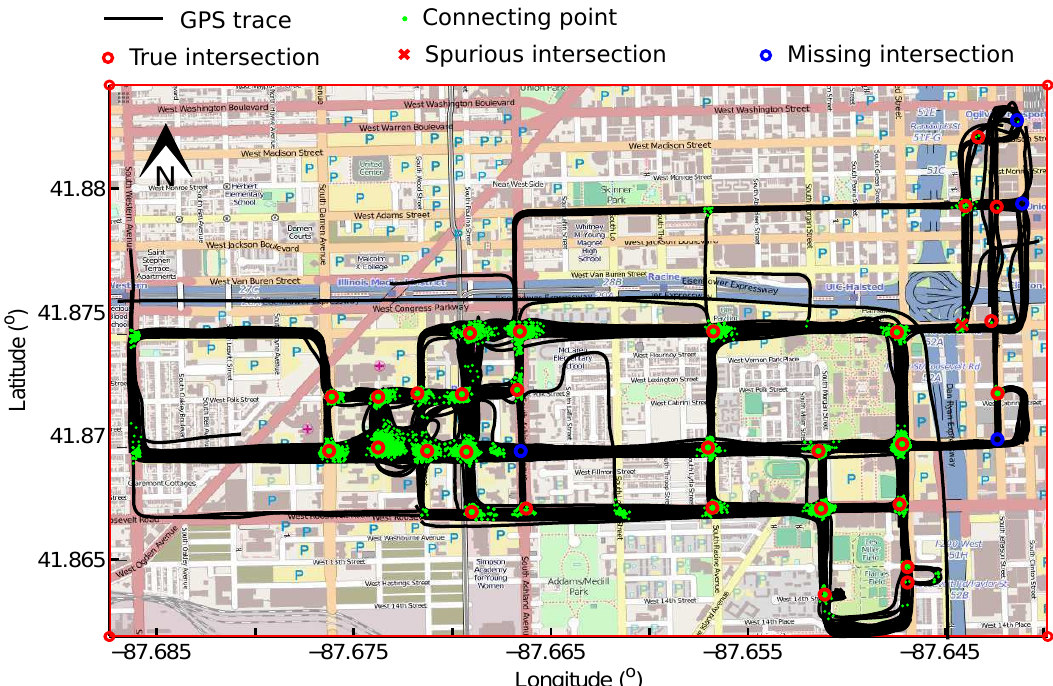
Figure 10. Intersections. In total, 30 intersections are detected, including 29 true intersections shown with red circles and 1 spurious intersection with a red cross. Four ground truth intersections, indicated using blue circles, are detected